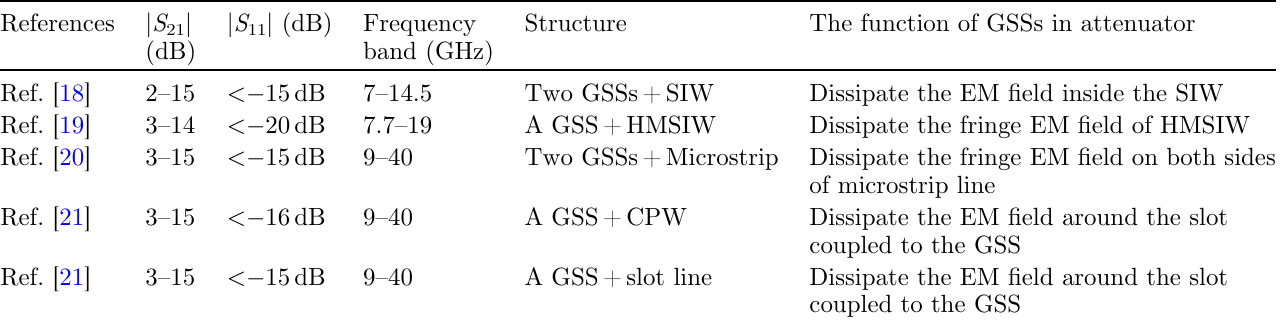
Table 2. Performance comparison of previously reported attenuators based on CVD-grown graphene.